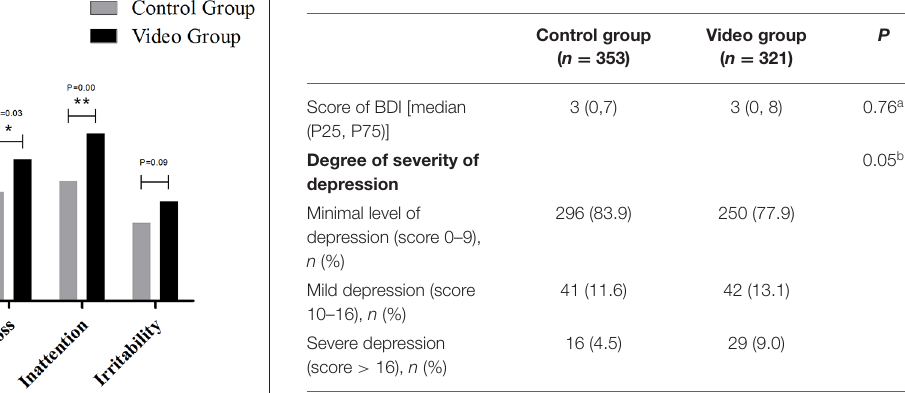
TABLE 4 | Score of Beck Depression Inventory (BDI) for the two groups ( n =